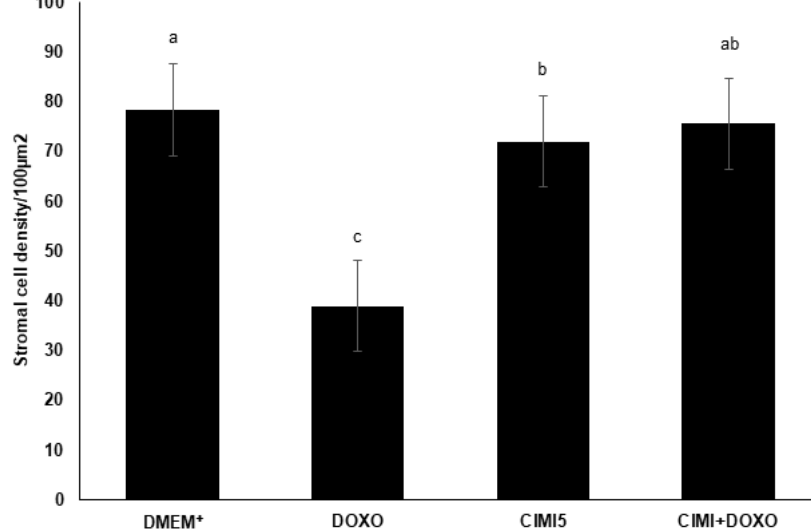
Figure 9. Stromal cell density on ovarian tissues (n = 09 ovaries per treatment) after culturing in DMEM + alone or with DOXO (0.3 µ g/mL), CIMI (5 ng/mL) and both CIMI and DOXO. Stromal density was analyzed using the Kruskal-Wallis test, followed by Dunn’s comparison. a, b, c different lowercase letters indicate statistically significant differences between treatments ( p < 0.05).